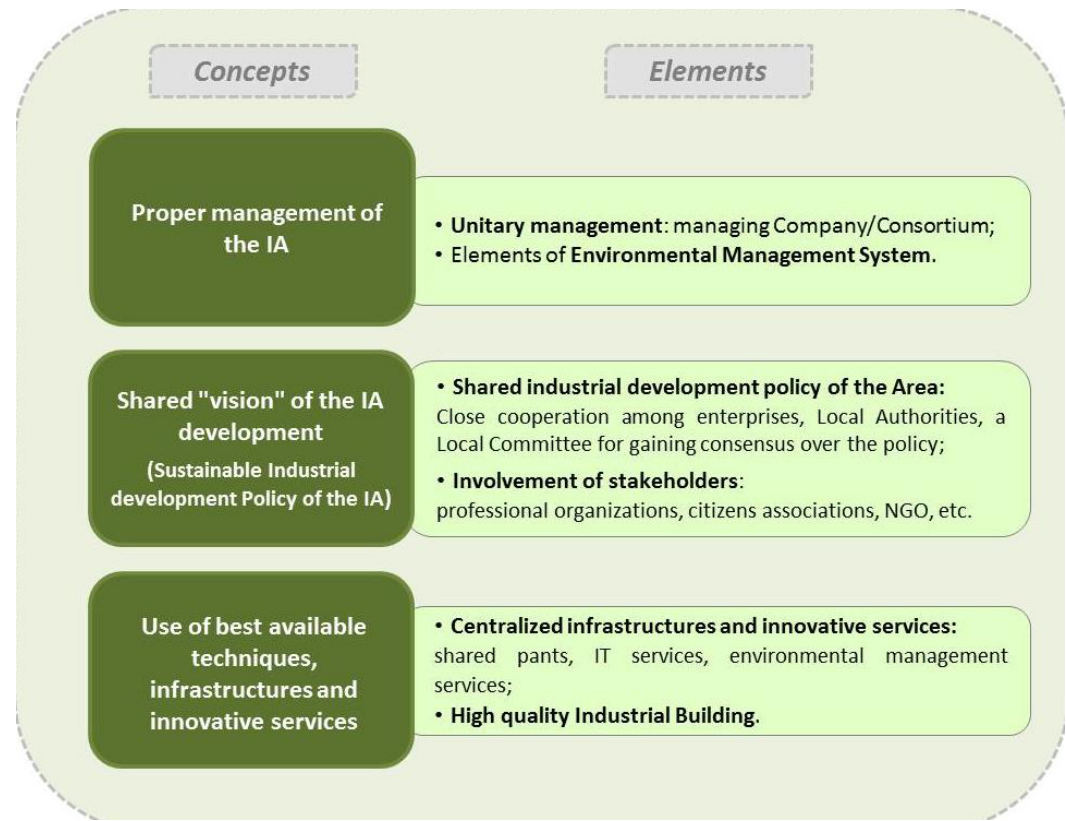
Figure 11. Key concepts and elements of a sustainable